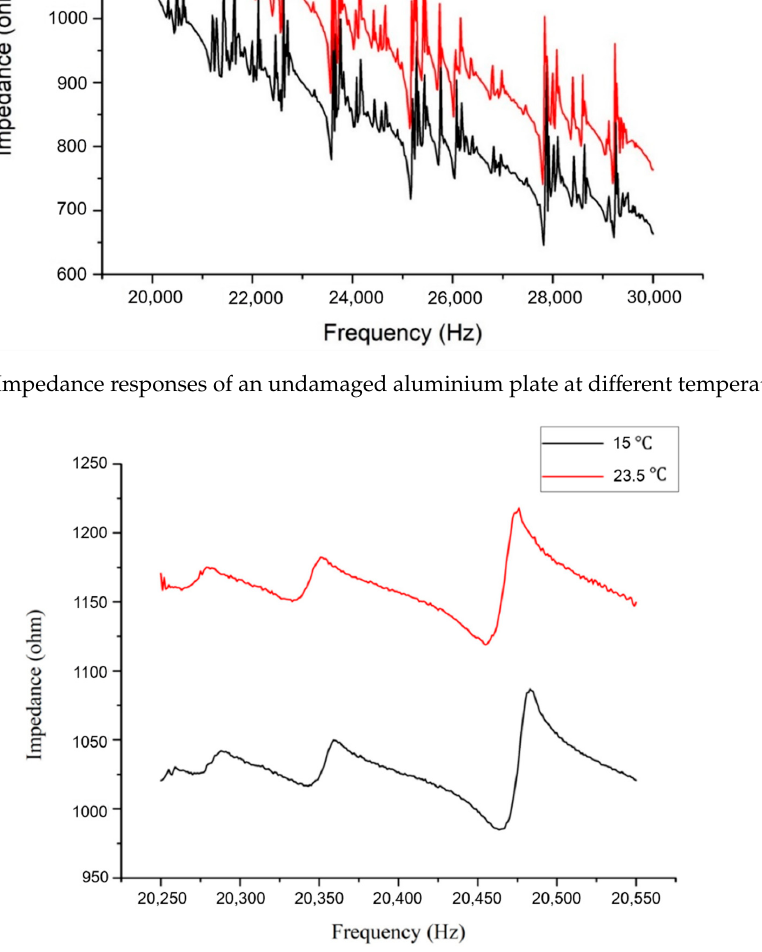
Figure 14. Impedance responses of a damaged aluminium plate at different temperatures.